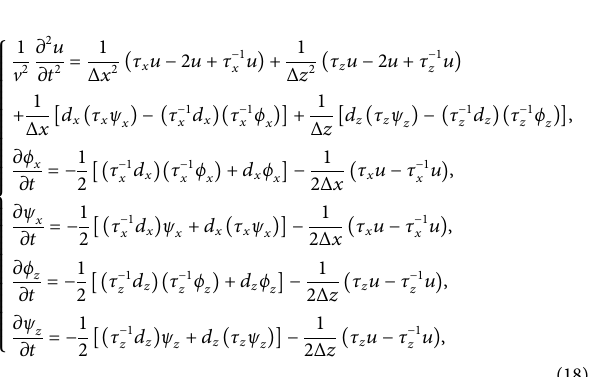
Frontiers in Earth Science |